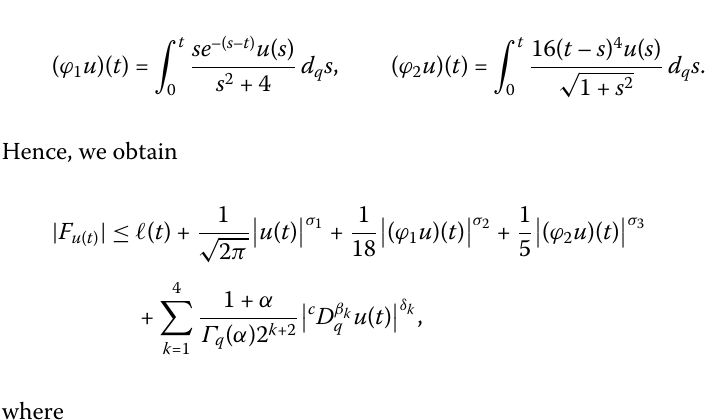
and n = 35 of Algorithm 6